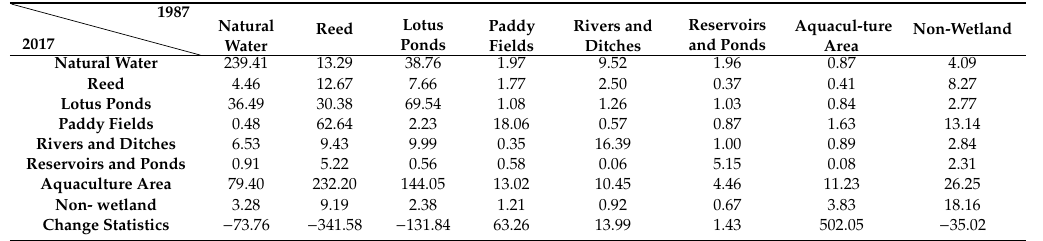
Figure 3. The LUCC of Nansi Lake wetland from 1987 to 2017. ( a ) shows the area percent change of three categories and ( b ) shows the area percent change of eight subcategories of Nansi Lake wetland from 1987 to 2017. Table 4. The area transfer matrix of land use types in Nansi Lake wetland from 1987 to 2017 (km 2 ). The numbers represent the area of land use change, positive and negative numbers in change statistics represent the increased and decreased areas of the corresponding land use types.